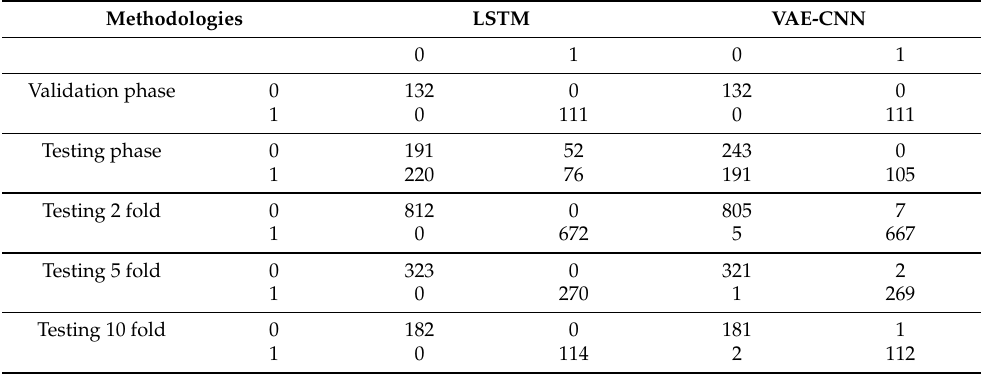
Table 4. Confusion matrix for two-class (normal or abnormal) classification.